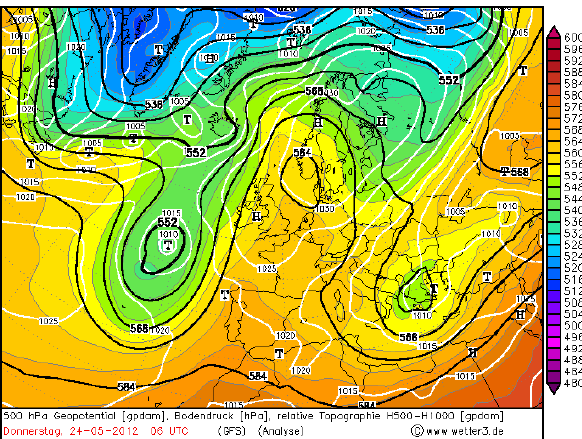
Figure 4. Geopotential height at 500hPa (black lines), surface pres- sure (white lines) and thickness (colour map) at 06:00UTC on 24 May 2012 from the GFS analysis. Figure 5. GNSS–IWV for 22–29 May 2012 at Lovech, Bulgaria.